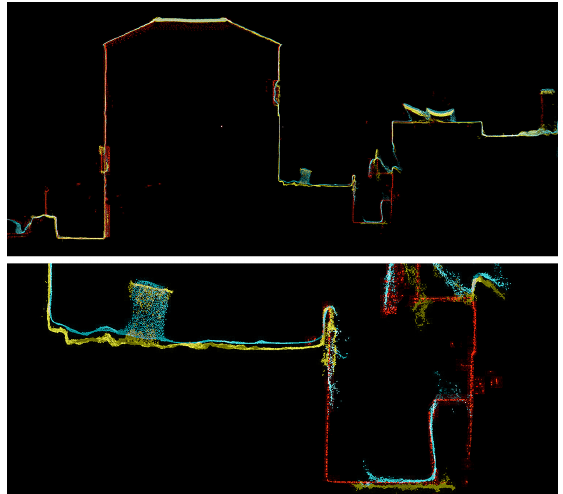
Figure 17: The overlapping on elevations. The Faro line section (red), the Phantom (blue) and the Spark